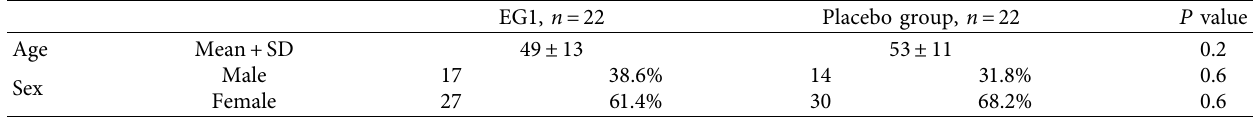
Table 1: Demographic data of both groups.